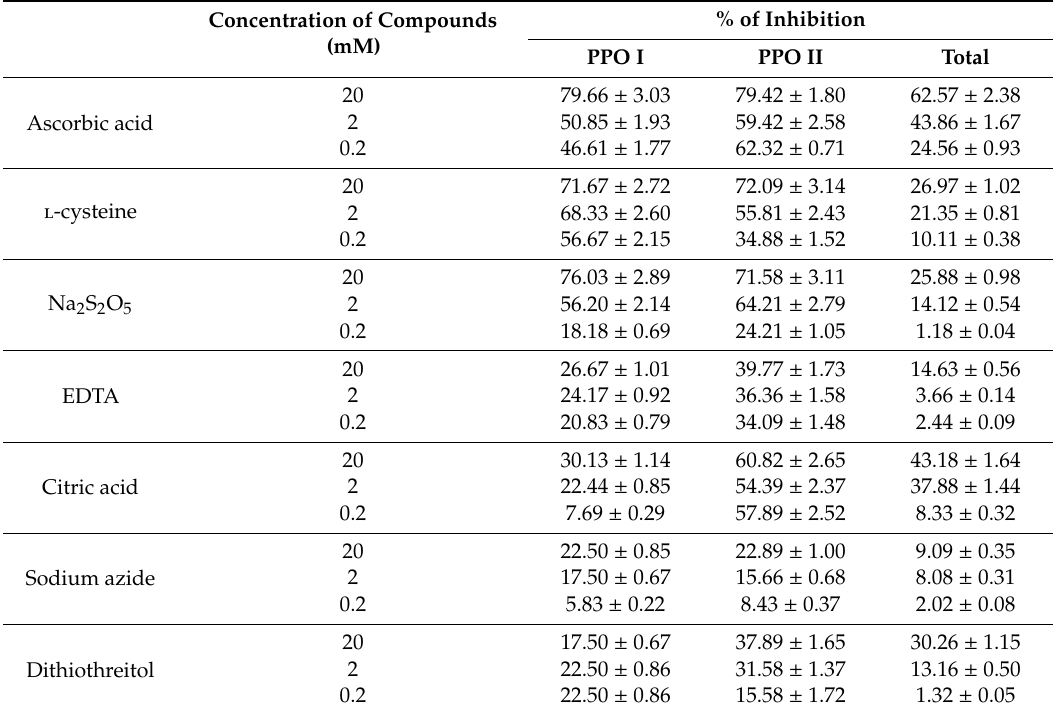
Table 3. E ff ects of various antibrowning agents on the activity of lentil sprout PPOs. Concentration of